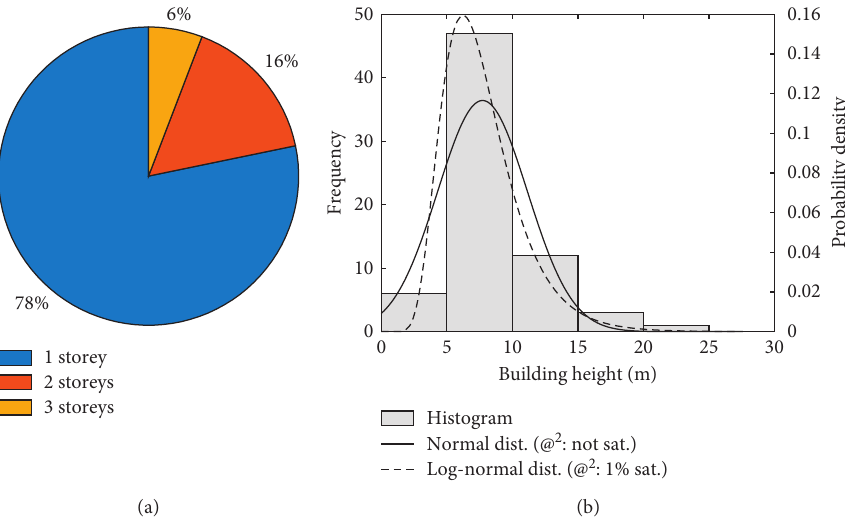
Figure 10: (a) Number of storeys. (b) Histogram and probability distributions associated with the number of storeys and building height.